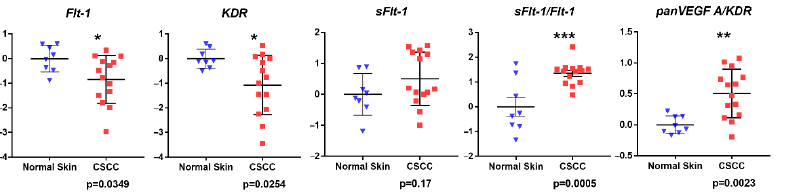
Figure 5. Relative expression of VEGF/PLGF receptor mRNAs. Relative expression of Flt-1 , sFlt-1 , and KDR mRNs was estimated by qRT-PCR in cDNAs derived from FFPE sections of NHS and CSSC tissue. Results are shown as relative to mean 18S rRNA-normalized expression in NHS controls, calculated using ∆∆ Ct method; similarly, Flt-1 variant or panVEGF-A : KDR ratios were calculated by internal normalization to expression of full-length Flt-1 or KDR , respectively. Vertical axes represent expression in CSSC relative to NHS on a log 10 scale. Blue triangles represent normal skin samples; red squares represent CSCC samples. p values are from two-sided unpaired Student’s t -tests.